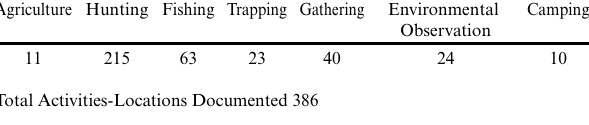
Table 1. Harvesting activities by location, documented in photo- pap database